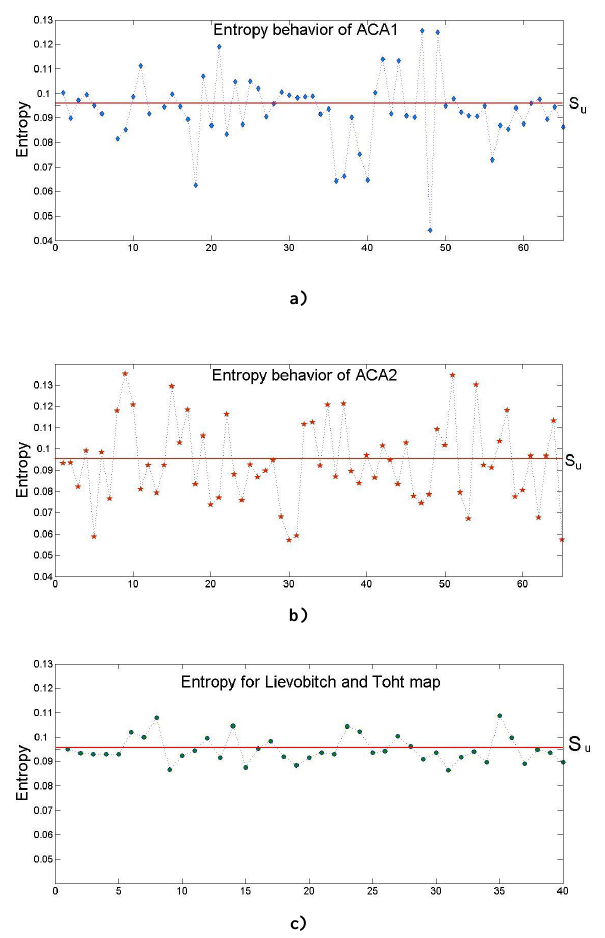
Figure 9. Entropy in NTD: (a) ACA1, (b) ACA2, (c) LT-map in the chaotic region. Fig. 9. Entropy in NTD: (a) ACA1, (b) ACA2, (c) LT-map in the chaotic